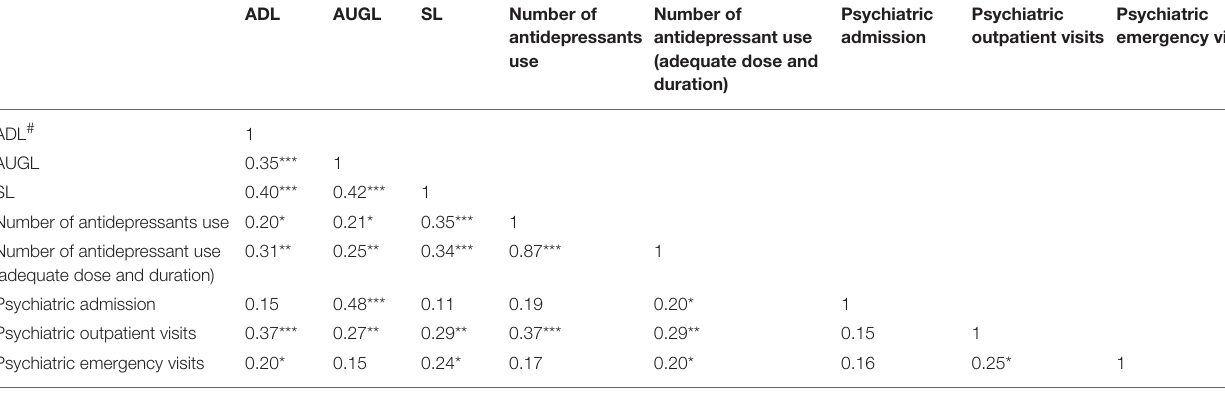
TABLE 2 | Correlation matrix between categories of psychotropics dissection and clinical features within 2-year of disease onset. ADL AUGL SL Number of antidepressants use